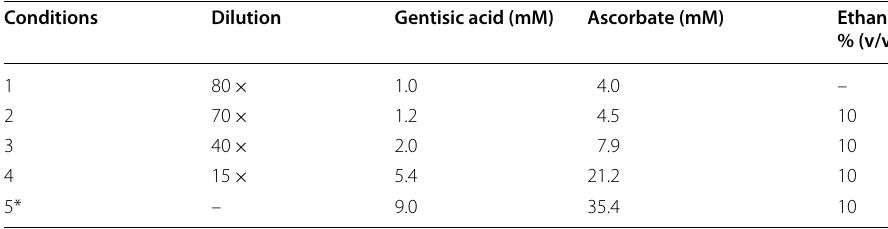
Table 3 Downscaled reaction conditions, optimized for clinical